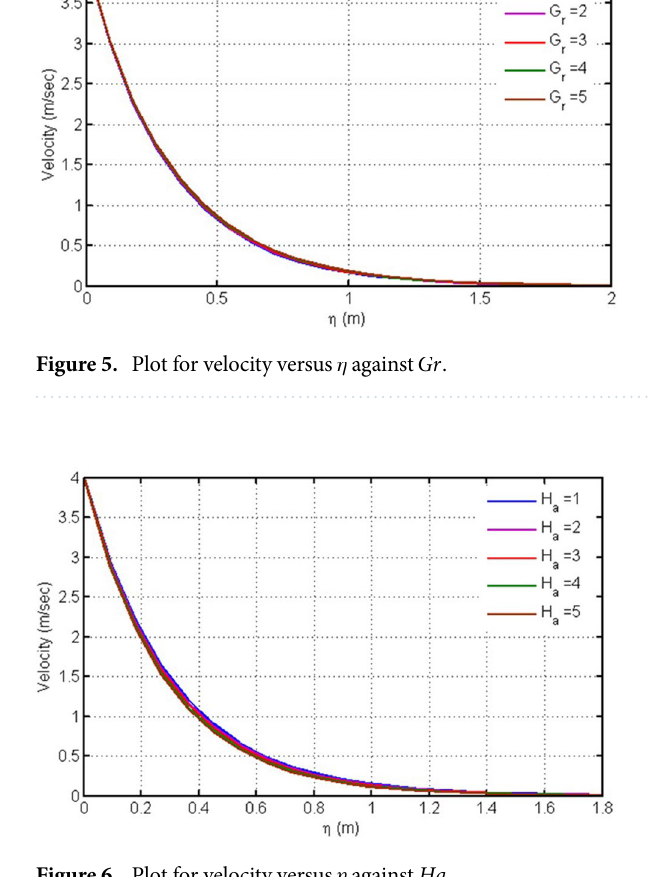
Figure 6. Plot for velocity versus η against Ha .